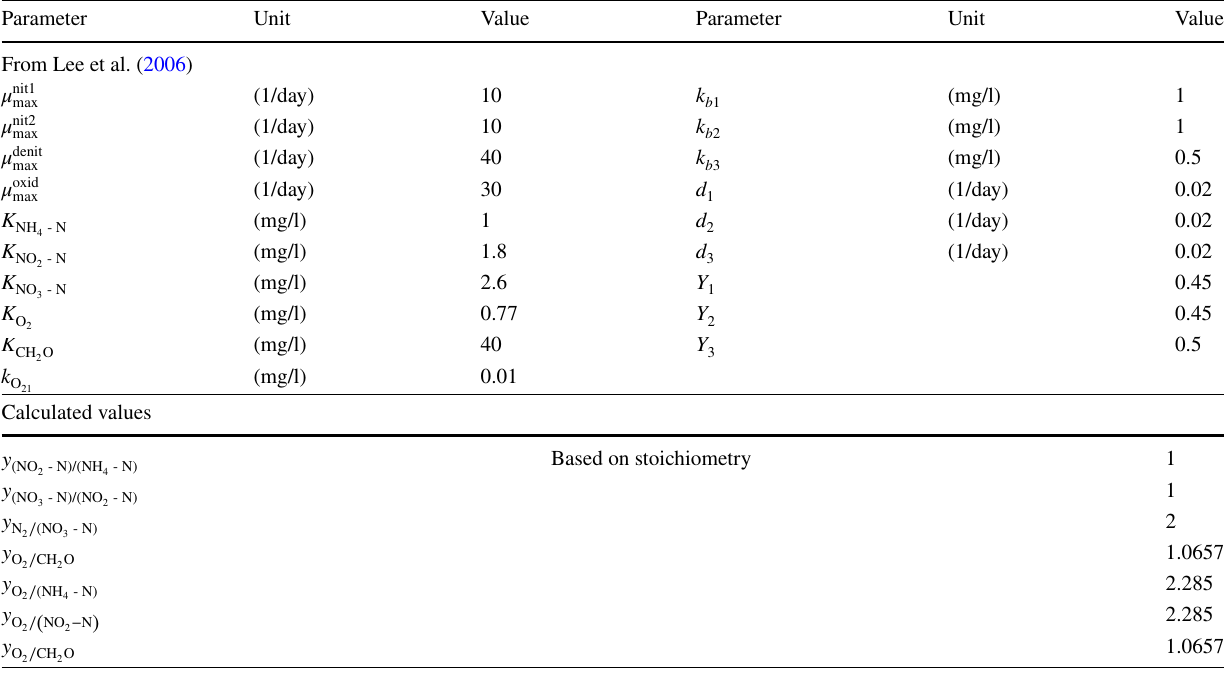
Table 3 Summary of Monod kinetics reaction parameters used for the present